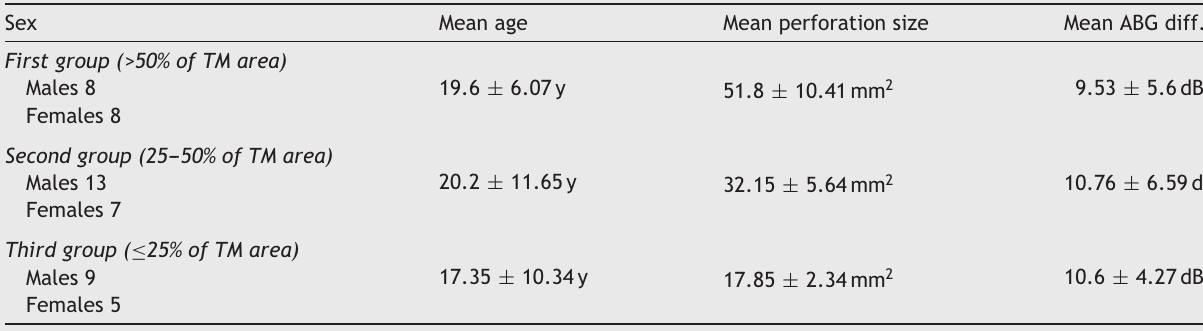
Table 1 Demographic characters of patients among three groups. Sex Mean age Mean perforation size Mean ABG diff. First group (>50% of TM area) Males 8 Second group (25---50% of TM